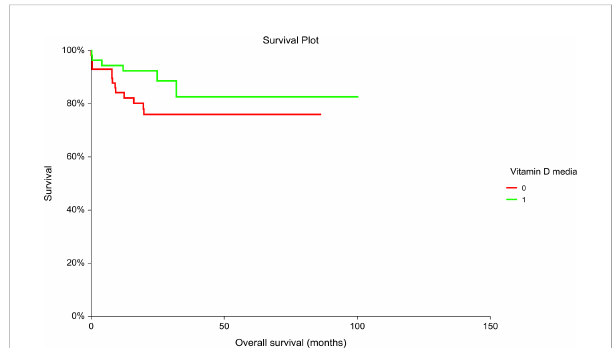
FIGURE 2 Kaplan – Meier estimates of probabilities of overall survival according to plasma vitamin D levels in TGCT patients (N = 120). Patients with plasma vitamin D concentration above median had non-signi fi cantly better OS as compared to patients with lower vitamin D concentration, [HR] = 2.06, 95% CI (0.84 – 5.06), p = 0.135; 0 = plasma vitamin D concentration below median, 1 = plasma vitamin D concentration above median). HR, hazard ratio; TCGT, testicular germ cell tumor; OS, overall survival; 0, plasma vitamin D concentration below median; 1, plasma vitamin D concentration above